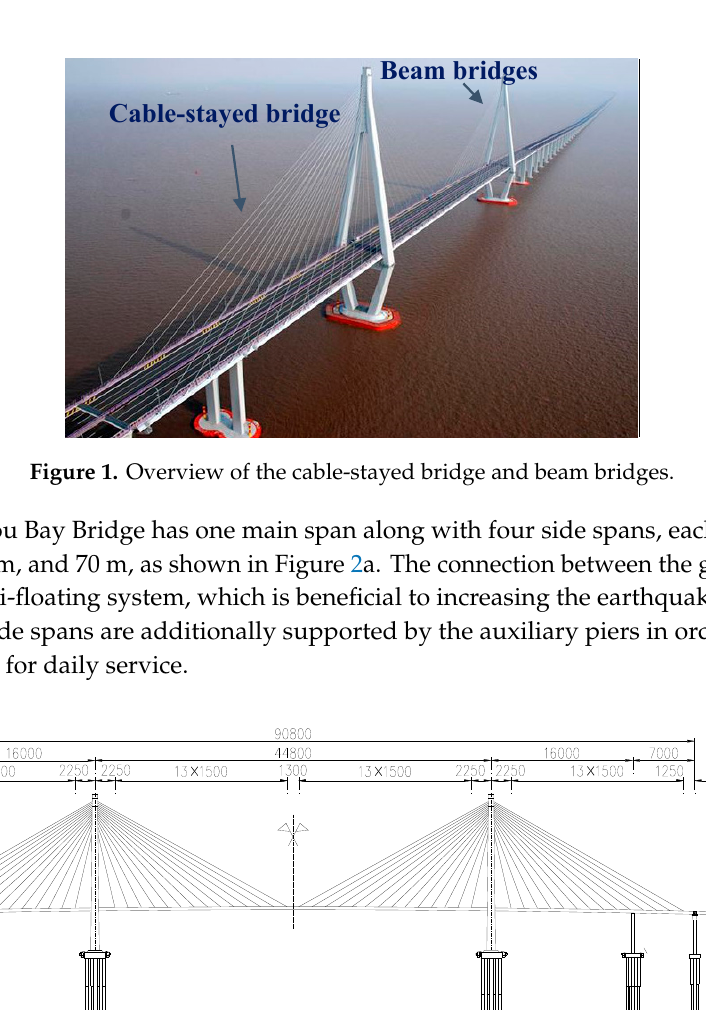
Figure 2. Layout of the Hangzhou Bay Bridge (Unit: cm). ( a ) Span arrangement of girder, ( b ) Pylon.